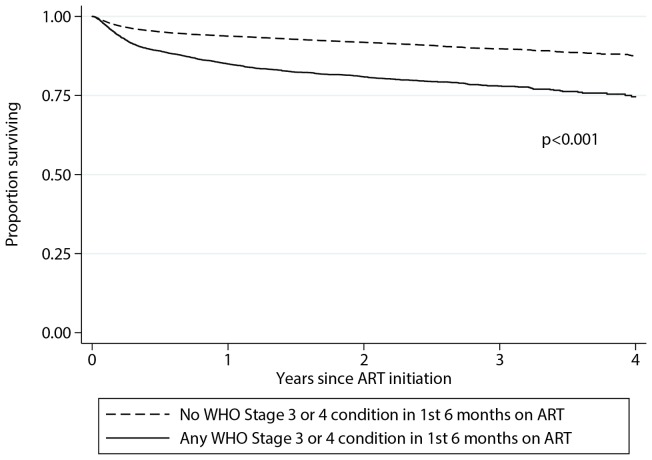
Kaplan-Meier survival analysis comparing those with a diagnosis of any WHO stage 3 or 4 condition within the first 6 months after ART initiation and those without.